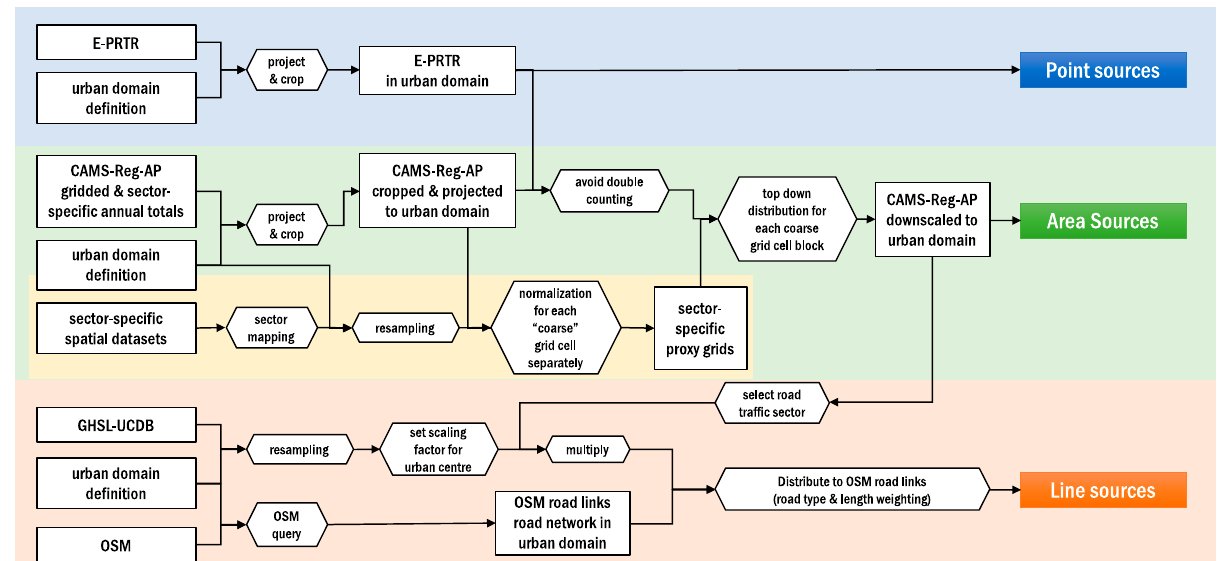
Figure 2. Schematic representation of the UrbEm hybrid approach for downscaling regional emission inventories to arrive at urban-scale emission inventories including point, area, and line sources.